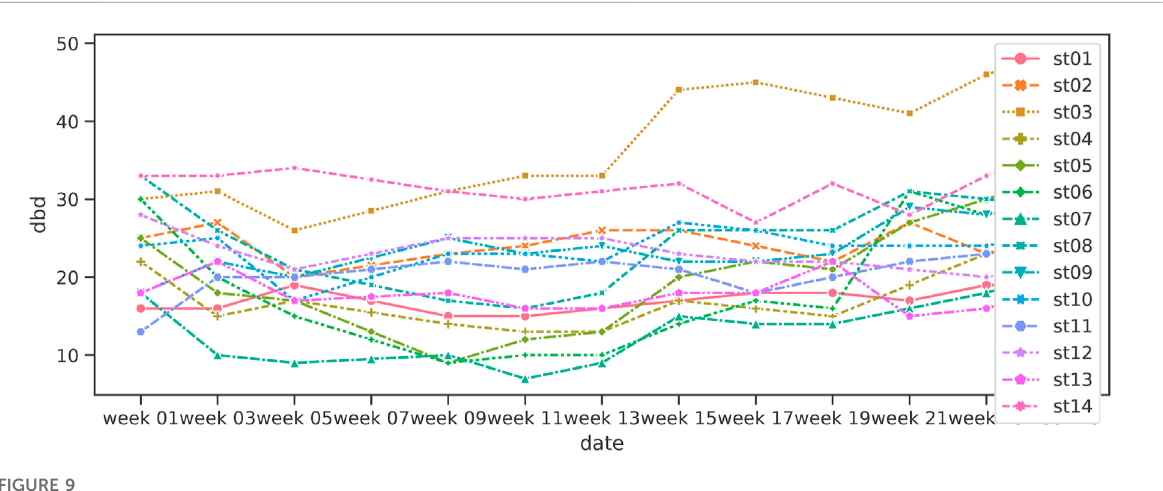
FIGURE 9 Variation of DBD in Shiritori